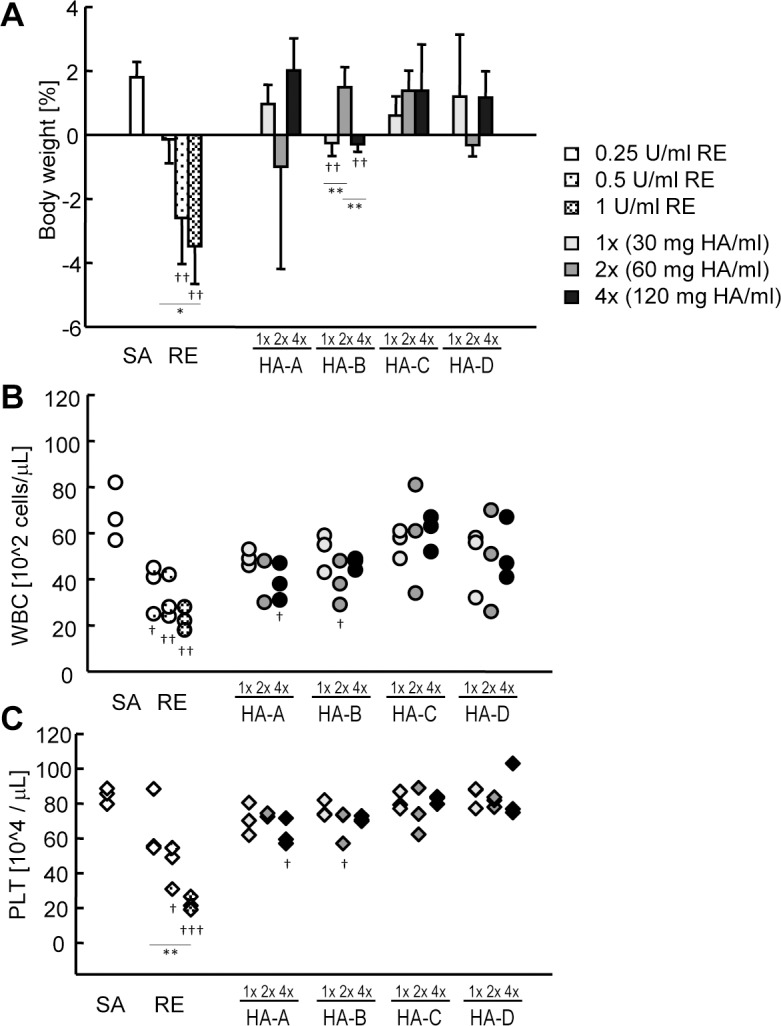
Abnormal toxicity test (ATT) and hematological tests of influenza vaccine-treated rats.The effects of RE, HA bulk materials, and SA treatment were measured using ATT, LTT and platelet (PLT) counts. Three rats per group were used, and were analyzed at day 1 after vaccine administration. (A) Changes in rat body weight were assessed as the percentage increase or decrease, and are indicated by the mean change ± S.D. WBC (B) and PLT (C) of peripheral blood were measured and plotted. Each symbol corresponds to an individual rat. Symbols filled with a few spots, a medium amount of spots, and many spots indicate 0.25, 0.5, and 1 U/ml of RE. Pale gray, gray, and black in each symbol indicate 1x, 2x, and 4x concentrated HA bulk materials. One blood sample of HA-A (2x) was clotted and omitted from LTT and PLT counts. * P < 0.05, ** P < 0.01. † P < 0.05 versus SA, †† P < 0.01 versus SA, ††† P < 0.001 versus SA.